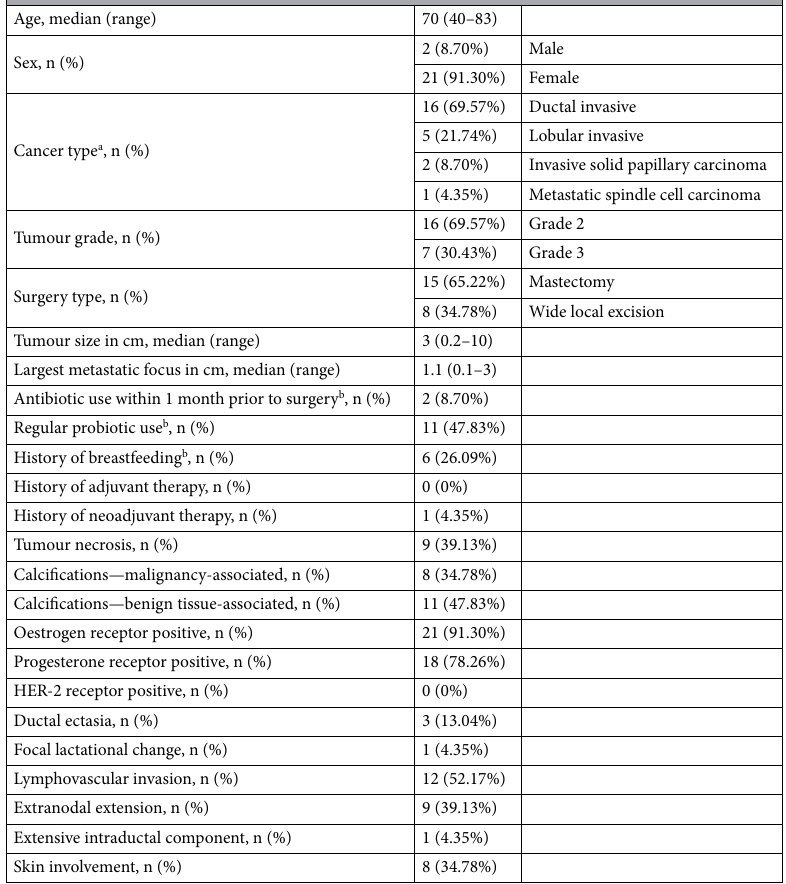
Table 1. Biographical, histological, surgical, and medical information for enrolled breast cancer patients. a Some patients had overlapping cancer types (e.g., both lobular carcinoma and ductal invasive carcinoma). b One patient did not provide